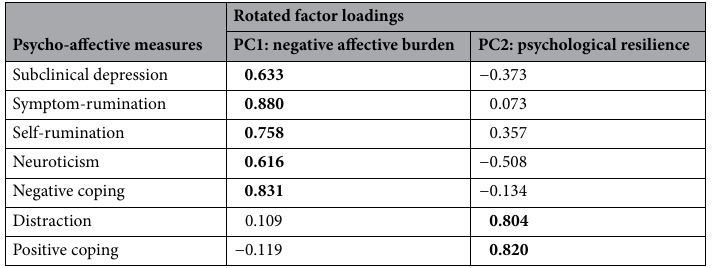
Table 1. Summary of principal component analysis to extract the negative affective burden composite for the entire sample. Factor loadings pertaining to a factor appear in bold. PC principal